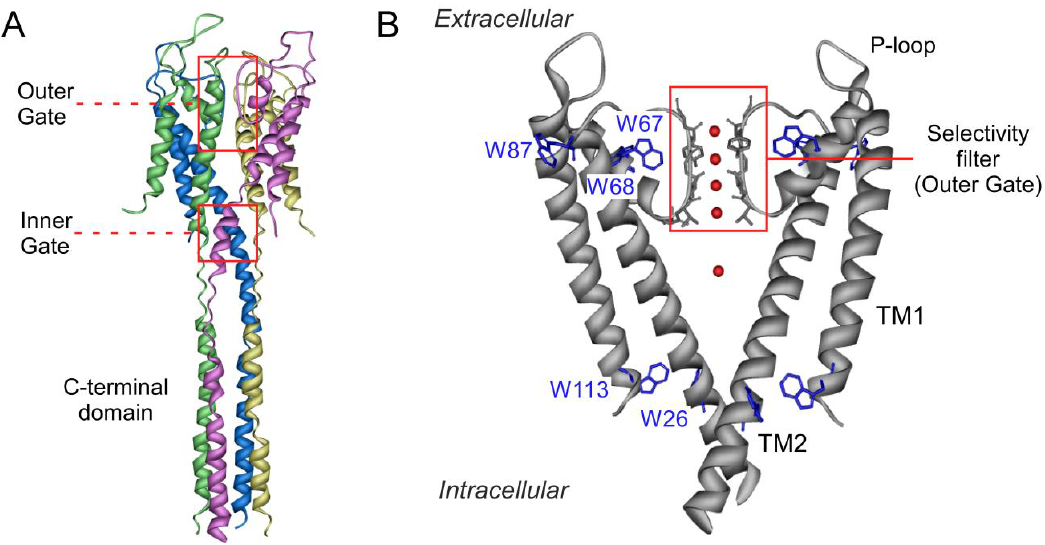
Figure 1. Schematic structure of the potassium channel KcsA. Panel A shows a side view of the full-length tetramer (PDB entry: 3EFF). Each monomer is highlighted in a different color. The location of the outer and inner gates, the latter in its closed conformation, is indicated by red squares. Panel B zooms in on the transmembrane portion of the channel (only two of the four identical subunits have been drawn for clarity) (PDB entry: 1K4C). Each monomer exhibits two transmembrane helices (TM1 and TM2), connected by the P-loop region and the selectivity filter (highlighted in red). Tryptophan residues are colored in blue and cations within the filter and in the channel vestibule appear as red spheres.